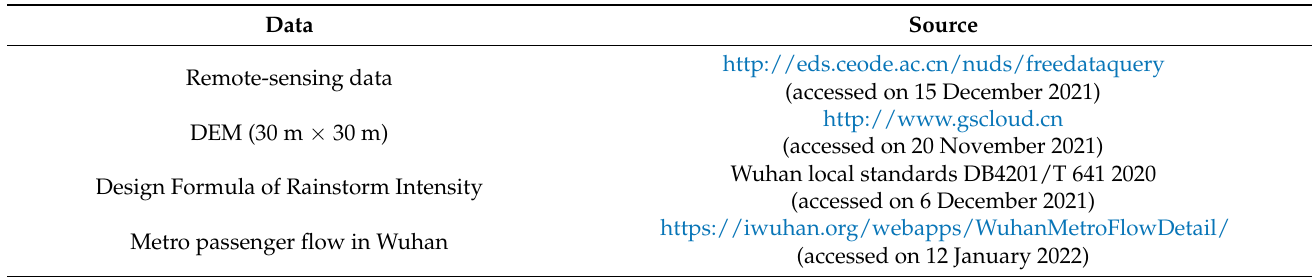
Table 3. Data sources of the research in this